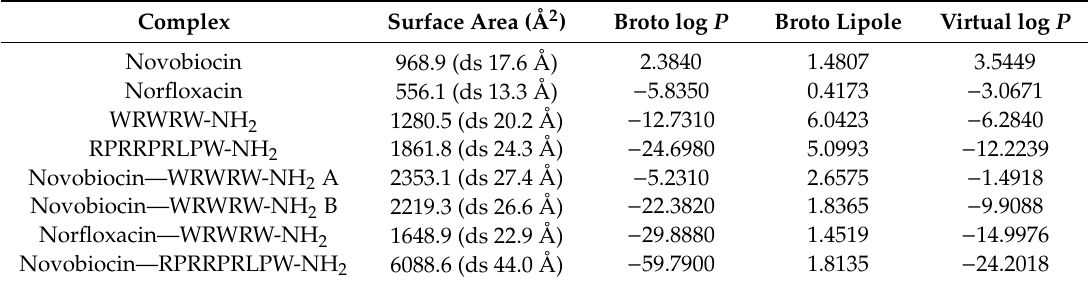
Table 2. Molecular lipophilicity maps obtained for the most representative complexes and for the free